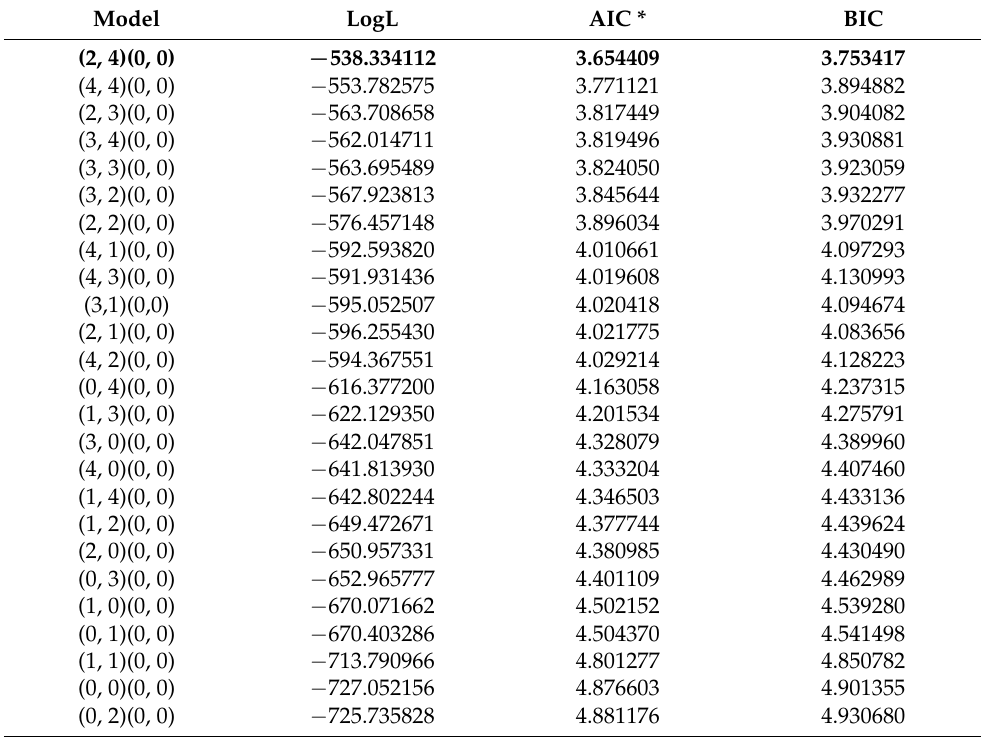
Table 3. The computed values of fitted